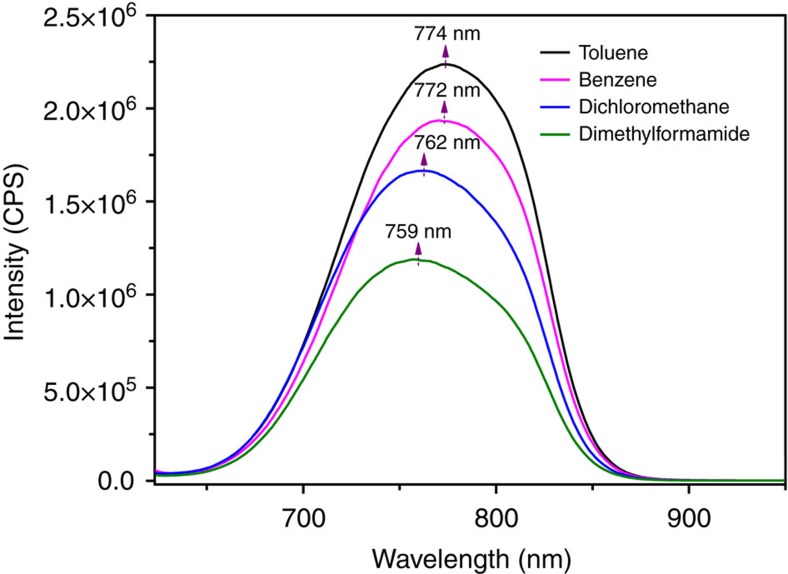
The solvent-polarity-dependent solution photoluminescence of Au60S6(SCH2Ph)36 nanoclusters.Not only the maximum emission wavelengths but also the photoluminescence intensities of Au60S6(SCH2Ph)36 nanoclusters in solution are dependent on the solvent polarity. Note: the excitation wavelength λex=514 nm.